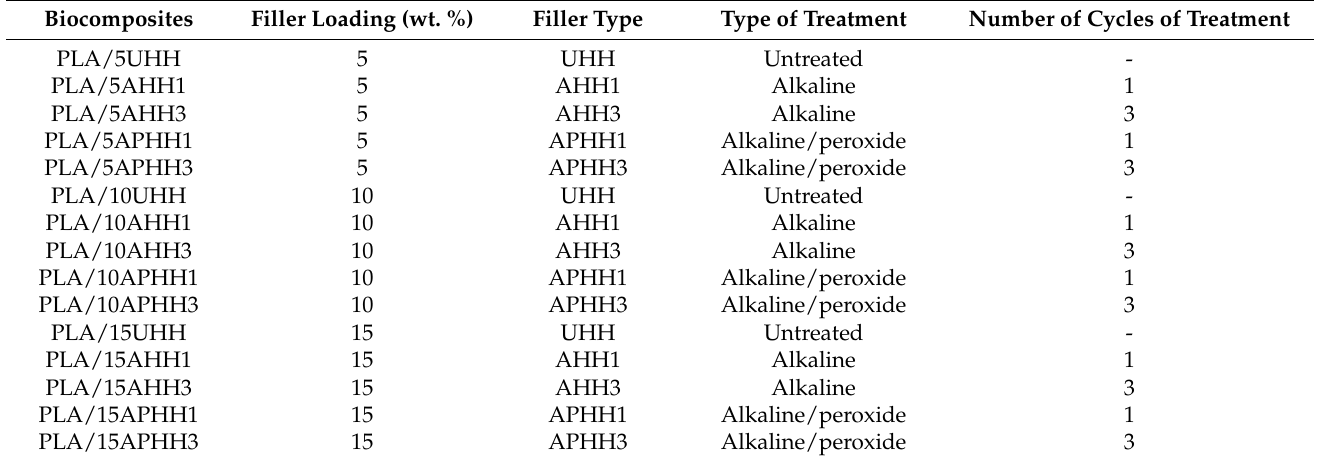
Table 1. Designated names for hemp hurd powders and prepared